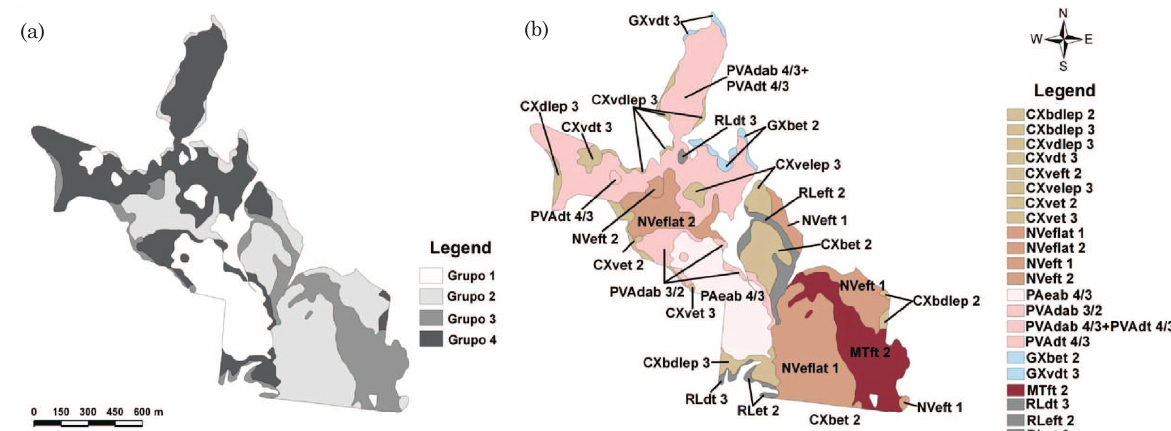
Figure 5. Digital soil map: a) compartment map and b) digital soil